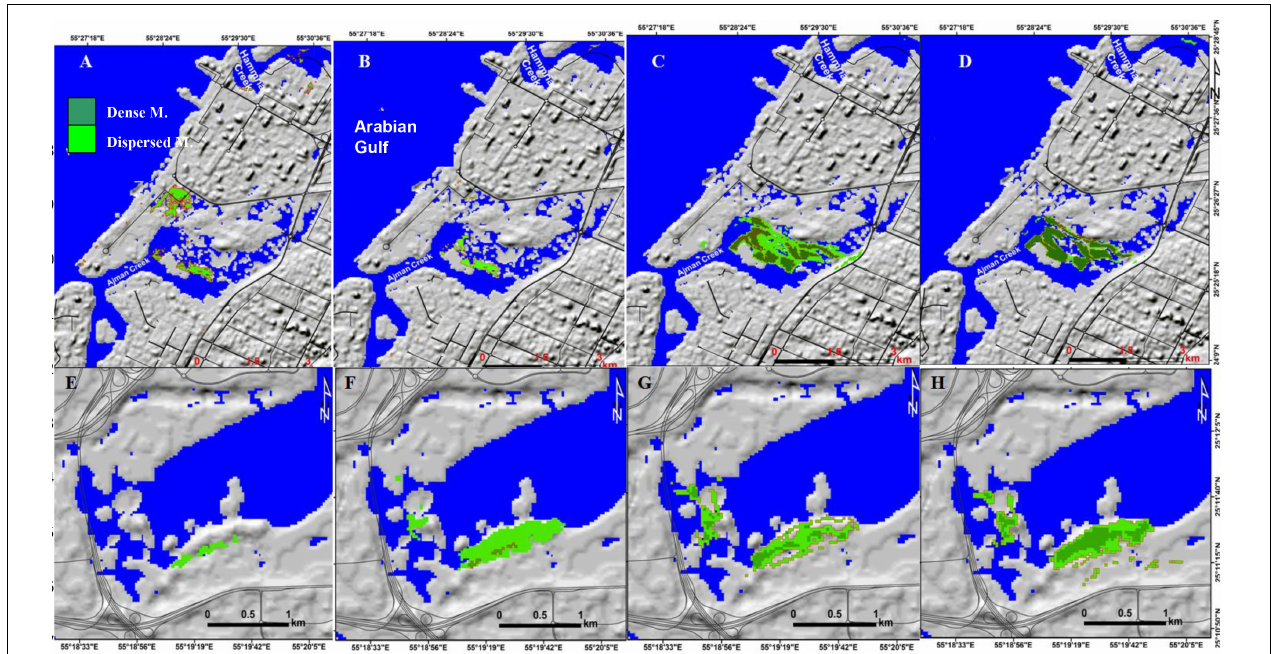
FIGURE 9 | Spatiotemporal variations of mangrove forests for the years in Ajman-Hammriah (A–D) , and Ras Al Khor (E–H) natural reserves for the years 1990, 2000, 2010, and 2019. Red polygons and dark green highlight dense